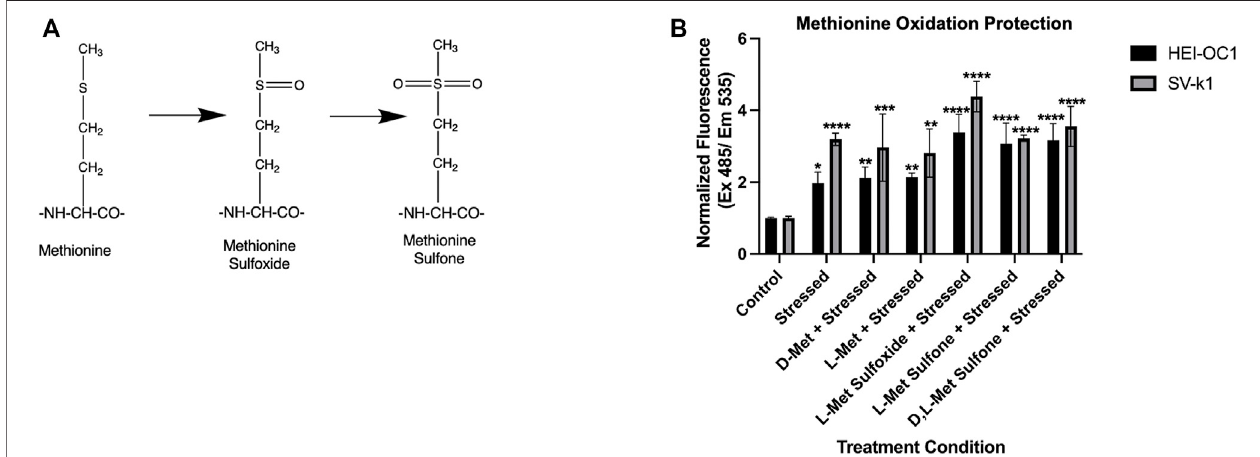
FIGURE 5 | Enantiomeric and oxidative state effects of methionine. (A) Potential oxidative states of methionine. (B) Evaluation of the effects of enantiomeric and oxidative state effects of methionine on oxidatively stressed cochlear cells. Data presented are mean ± SD. One-way ANOVA with Tukey ’ s multiple comparisons run for each cell type individually. HEI-OC1 ANOVA versus unstressed control: stressed p = 0.0209, D-Met p = 0.0061, L-Met p = 0.0051, L- Met Sulfoxide p < 0.0001, L-Met Sulfone p < 0.0001,and D, L-Met Sulfone p =0.0001. * p < 0.05, ** p < 0.01, **** p < 0.0001.SV-k1ANOVA versusunstressedcontrol: stressed p < 0.0001,D-Met p = 0.0004, L-Met p = 0.0011, L-Met Sulfoxide p < 0.0001, L-Met Sulfone p < 0.0001, and D, L-Met Sulfone p <